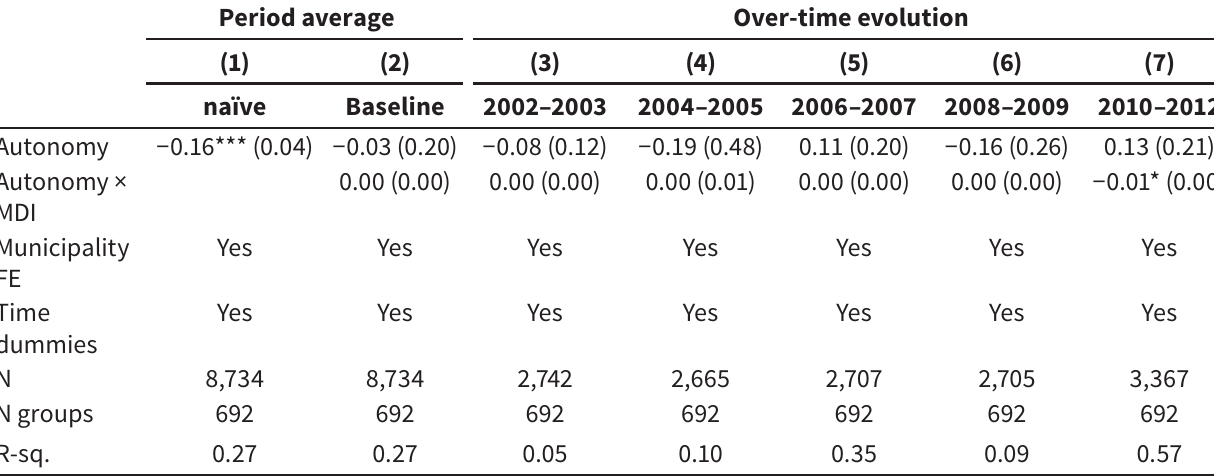
The effect of municipal autonomy on number of test takers (% change) Period